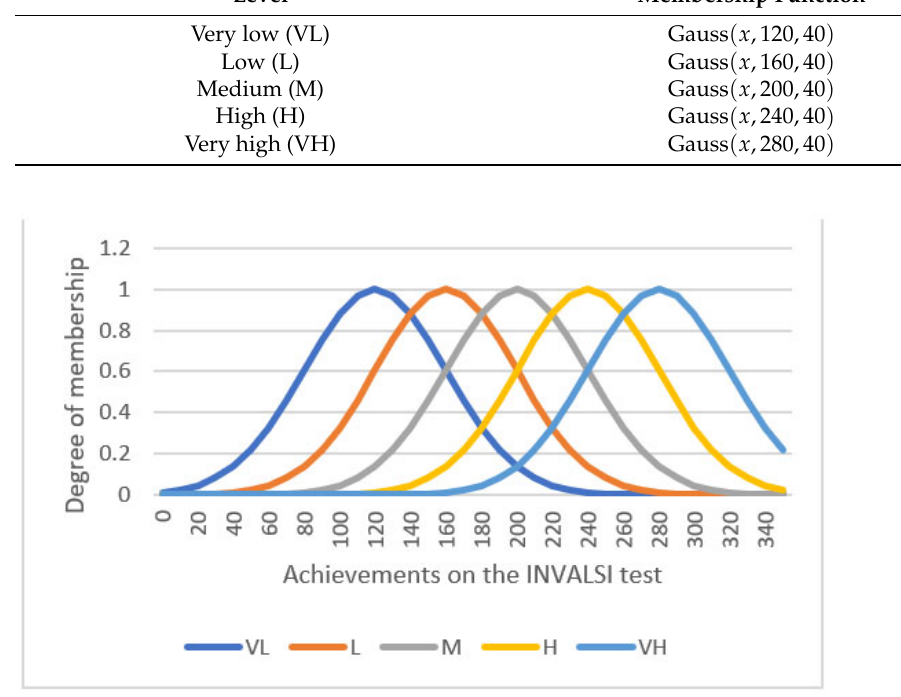
Figure 5. Plots of the membership functions for the fuzzification of crisp test scores.